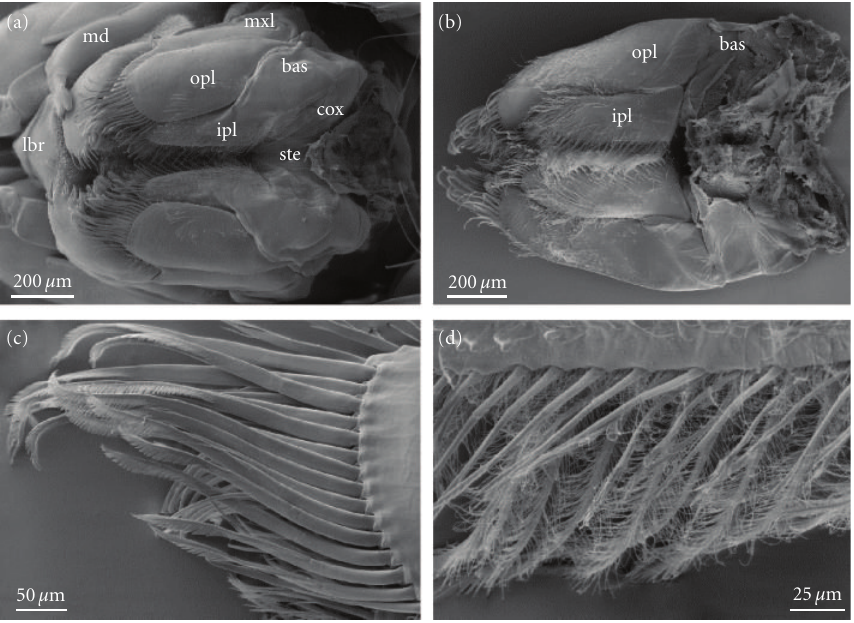
Figure 10: SEM images of maxillae of Echinogammarus berilloni : (a) maxillae in situ in posterior view; (b) maxillae in anterior view; (c) distal setation of outer plate of left maxilla in posterior view; (d) median setation of inner plate of left maxilla in posterior